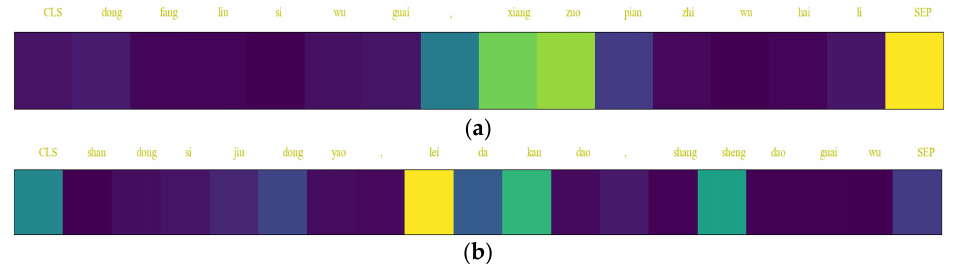
Figure 11. ( a ) Heat map of a tt ention results of a tt ention layer for single intention data. ( b ) Heat map of a tt ention results of a tt ention layer for multi-intention data.